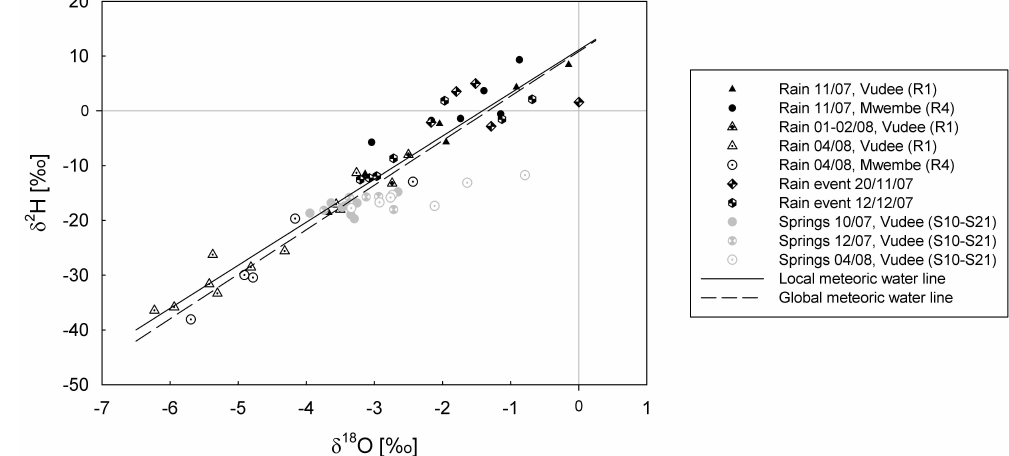
Fig. 3. Isotopic composition of rain water, sampled at Vudee (R1) and Mwembe (R4) throughout the study period as well as the composition of rain water sampled throughout the catchment during two events (20/11/2007 and 12/12/2007). Furthermore, the isotopic spring water composition of springs in Vudee (S10–S21) sampled at three occasions: at the beginning of WS1 (10/2007), the end of WS1 (12/2007) and in the middle of WS2